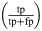
Forest plots of the positive and negative predictive values.The positive predictive value PPV was defined as (tptp+fp) and the negative predictive value NPV as (tntn+fn). tn: true negative; tp: true positive; fn: false negative; fp: false positive. All numbers have been rounded up or down to the closest second decimal.